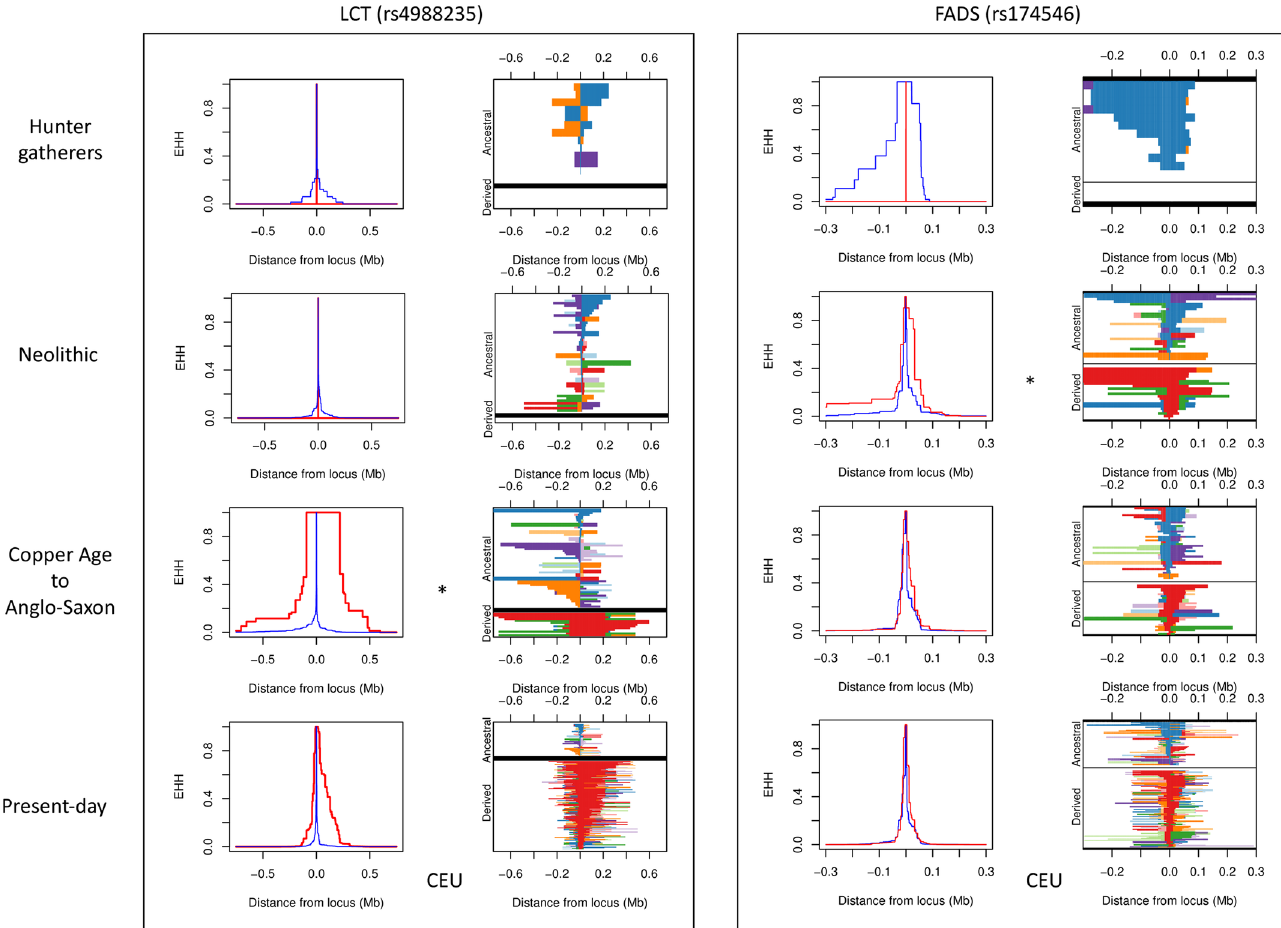
Fig 6. Extended haplotype homozygosity in regions under selection. Panels on the left represent the decay of EHH, or the probabilityof homozygosity at a certain base across 2 randomlychosen chromosomes in a population.Plots on the right represent existing haplotypesin a population,with the lower portion of the graph depictinghaplotypes with the derived allele(red) and the upper part showinghaplotypes carryingthe ancestral allele(blue). Uniquehaplotypes in a populationare not represented. Legend:CEU—Utah Residents(CEPH) with Northern and